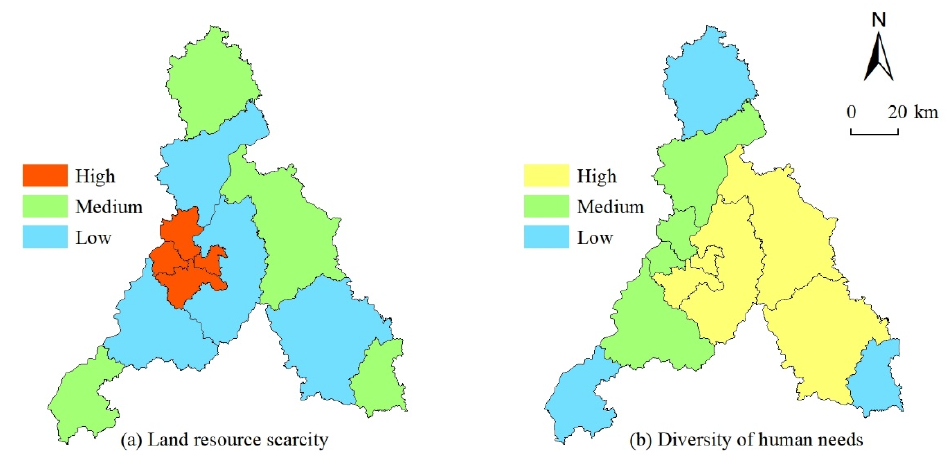
Figure 4. Scarcity of land resources and diversity of human needs.